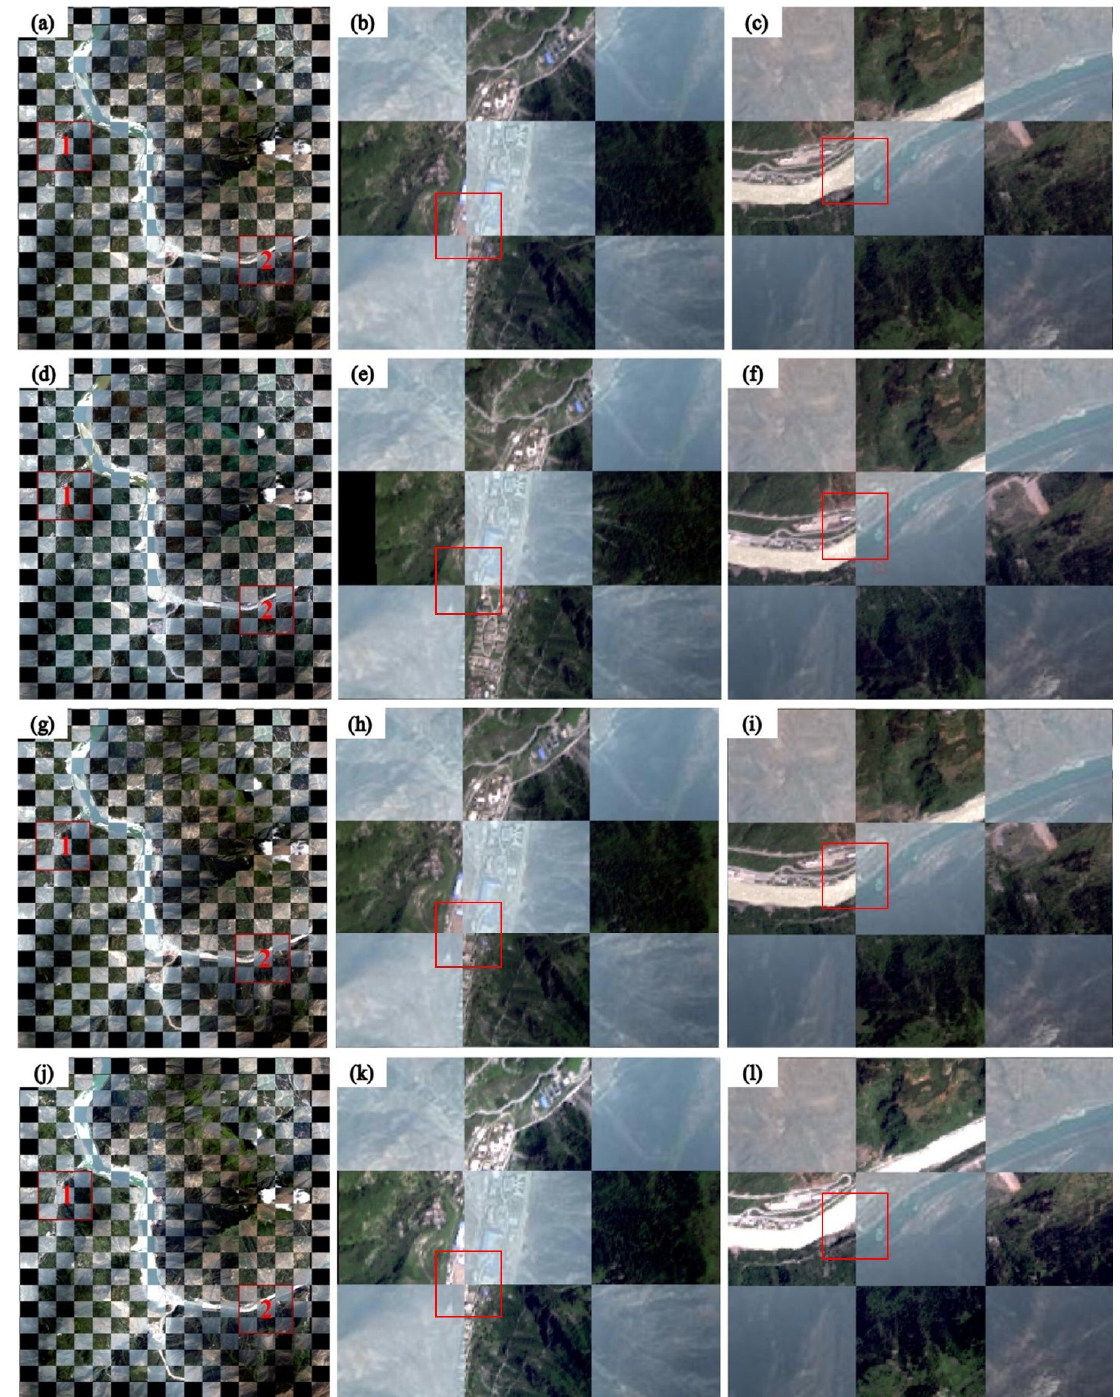
Figure 12. Checkerboard images for the P-D dataset. ( a ) Original image; ( b ) enlarged image of red box 1 in ( a ); ( c ) enlarged image of red box 2 in ( a ); ( d ) result for the proposed method; ( e ) enlarged image of red box 1 in ( d ); ( f ) enlarged image of red box 2 in ( d ); ( g ) result for the Patch-SIFT; ( h ) enlarged image of red box 1 in ( g ); ( i ) enlarged image of red box 2 in ( g ); ( j ) result for the SIFT; ( k ) enlarged image of red box 1 in ( j ); ( l ) enlarged image of red box 2 in ( j ); and ( m ) result for the SURF; ( n ) enlarged image of red box 1 in ( m ); ( o ) enlarged image of red box 2 in ( m ). The red boxes indicate the regions where noticeable differences can be observed.